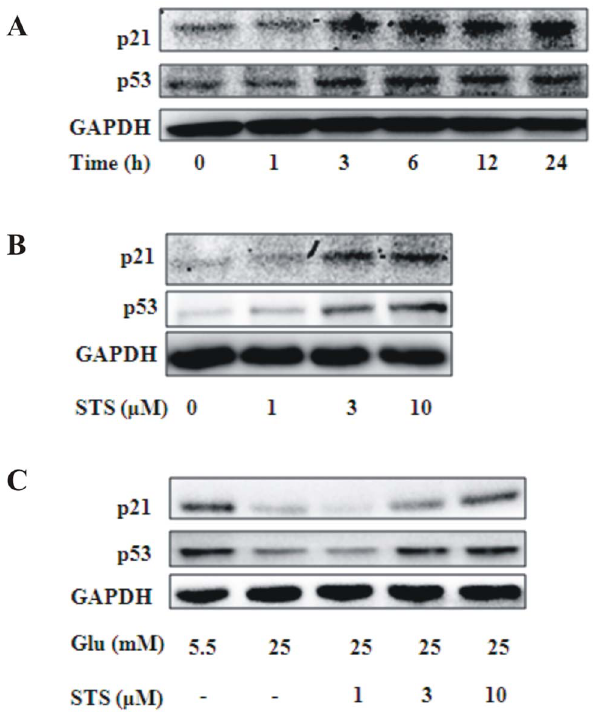
Figure 4. Effects of STS on cyclin-dependent kinase inhibitory proteins. (A) VSMCs were treated with STS (10 m M) for the indicated time-periods. Protein levels of p53, p21, and b -actin were determined using Western blot. (B) VSMCs were treated with different concentra- tions of STS for 24 h, and levels of p53, p21, and b -actin were deterimined. (C) VSMCs were treated with HG for 24 h in the presence of indicated concentration of STS. Expression levels of p53, p21, and b - actin were analyzed using Western blot. Results are representative of three independent experiments.